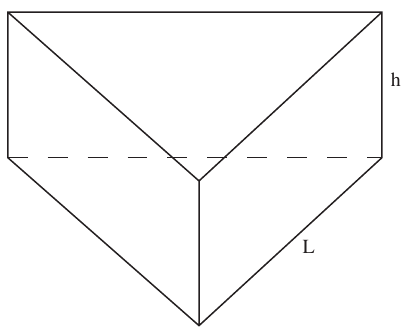
Figure 2. Prism with an equilateral triangle base used to simulate the grains of tungsten carbide (WC).